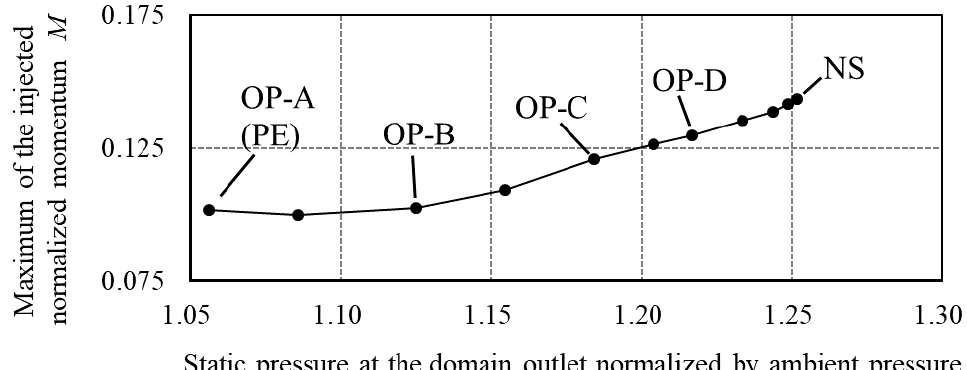
Figure 15. Variation in the injected flow momentum M, showing that M increases with compressor loading.